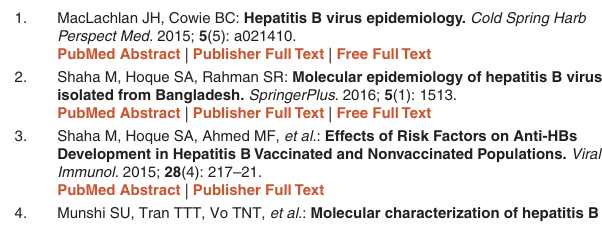
activity of the viral reverse transcriptase, and may not signify any